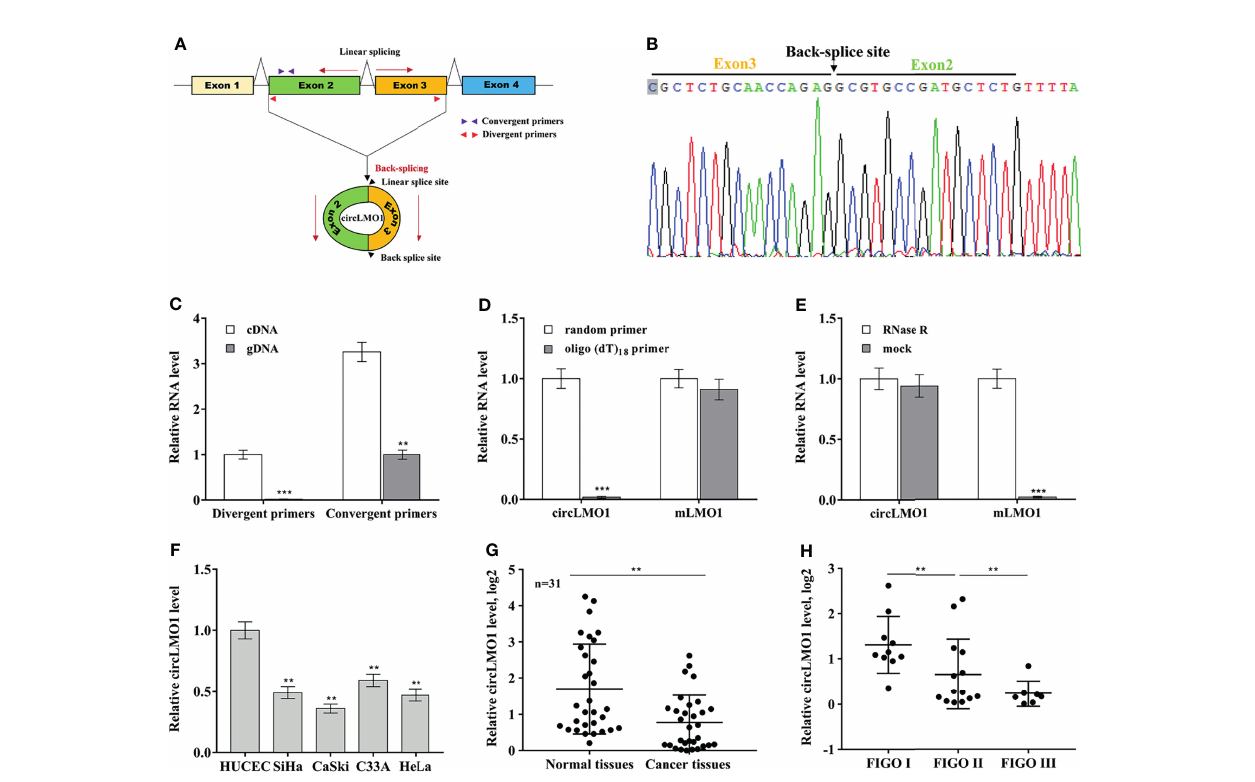
FIGURE 1 | Features of circLMO1. (A) Schematicdiagram of theformation ofcircLMO1. The qPCR primers used to evaluate the linear sequence ofcircLMO1, the convergent primers, are represented byred triangles. The qPCR primersused to evaluate the reverse splice site of circLMO1, the divergent primers, are represented by purpletriangles. (B) Sanger sequencing of the reverse splice site of circLMO1. (C) qPCR analysisof circLMO1 levelin DNA and cDNA derivedfromC33A cells using convergent primersand divergent primers. (D) Oligo (dT)18 primersor random primerswas usedto synthesize fi rst-strandcDNA, and then qPCR analysis was performed to evaluate the levelof circLMO1 and mLMO1 in these cDNAs. The value of the random primer isusedas a reference. (E) Total RNA was treatedwith RNase R,and then qPCR analysiswere performed to evaluate circLMO1 andmLMO1 level. (F) qPCR analysiswas performedto assess circLMO1 expression in variouscervical cancer cell lines (SiHa, CaSki,C33A, and HeLa) and normalcervical epithelial celllines (HUCEC). (G) qPCR analysiswas performedto assess circLMO1 level in cervical cancer tissues (n= 31) and matched normal tissues. (H) qPCR analysiswas performed to assess circLMO1 level indifferent FIGO stages of cervical cancer.*p< 0.05, **p < 0.01, ***p <